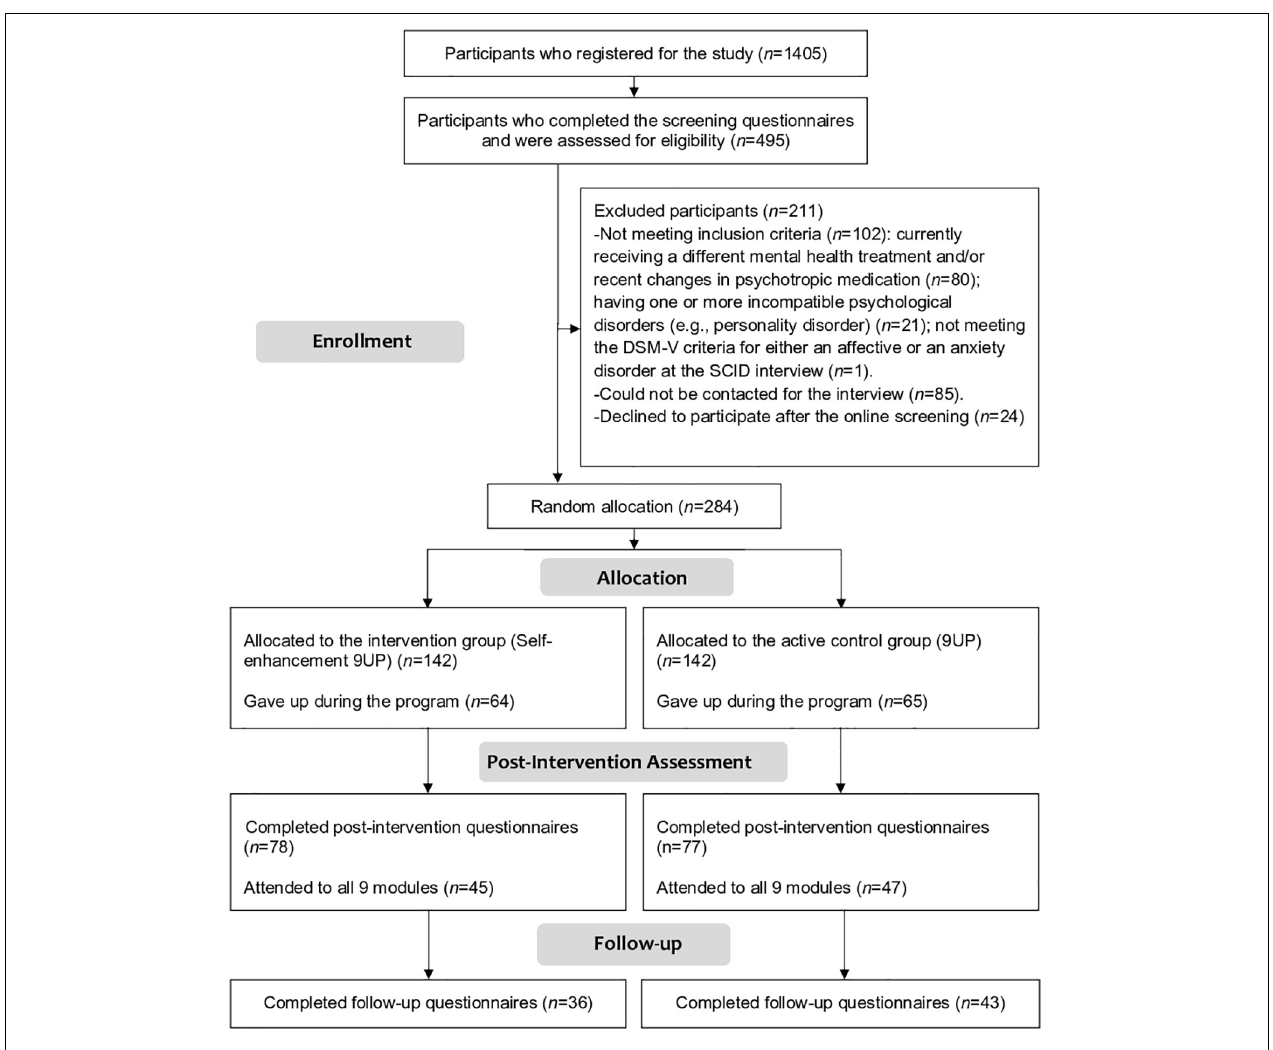
FIGURE 1 | The flowchart displaying participants’ cycle throughout the